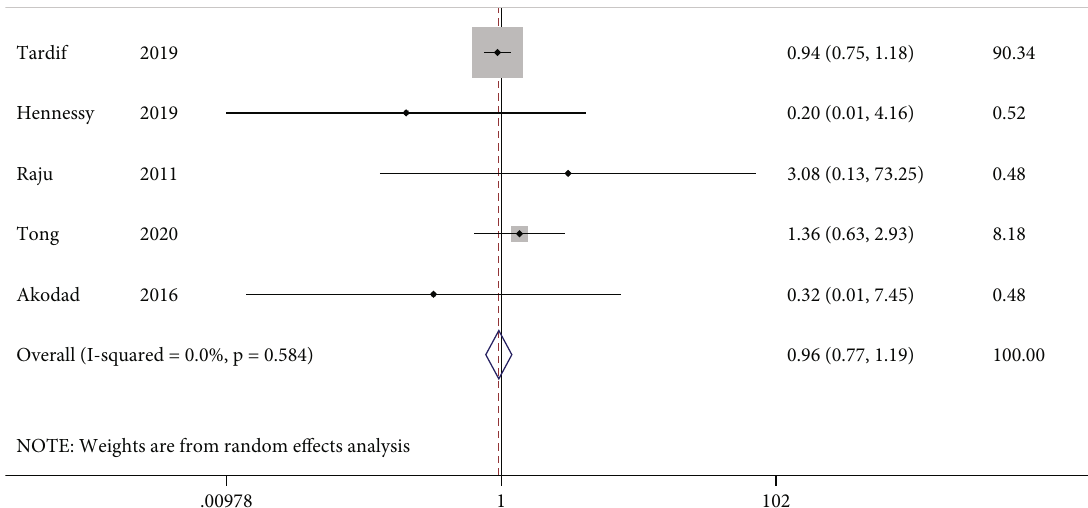
Figure 3: Forest plot displaying risk ratio and 95% con fi dence intervals for the impact of colchicine on primary composite endpoint in patients with acute coronary syndrome. RR: risk ratio; CI: con fi dence interval.